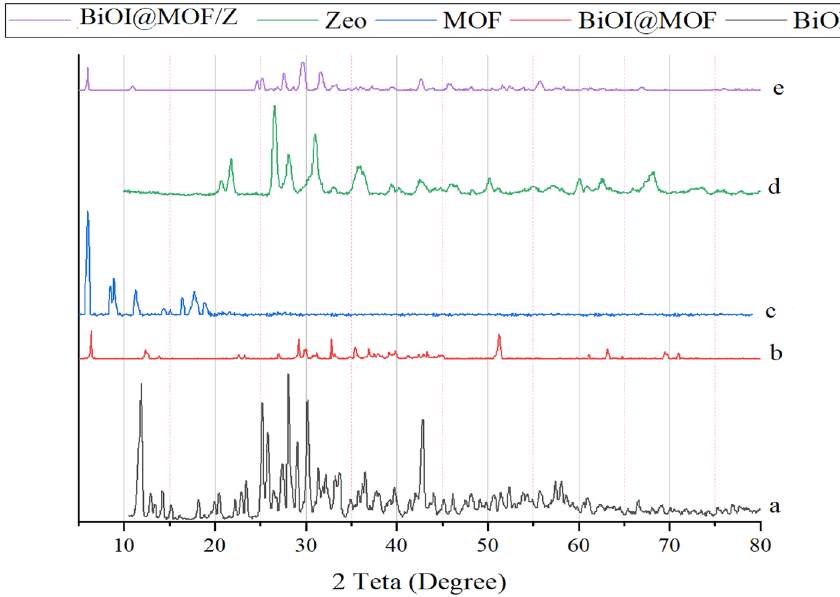
Figure 2. BiOI, MOF, Zeolite, BiOI@MOF, and BiOI@MOF/Z XRD